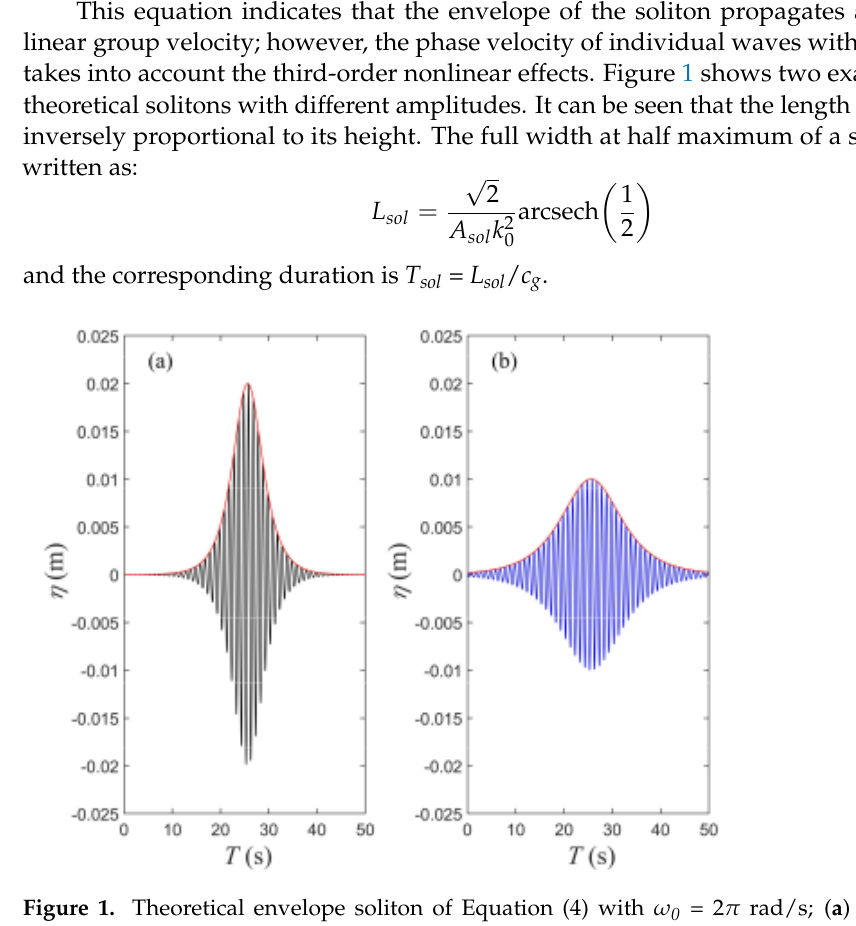
Figure 1. Theoretical envelope soliton of Equation (4) with ω 0 = 2 π rad/s; ( a ) A sol = 0.02 m; ( b ) A sol = 0.01